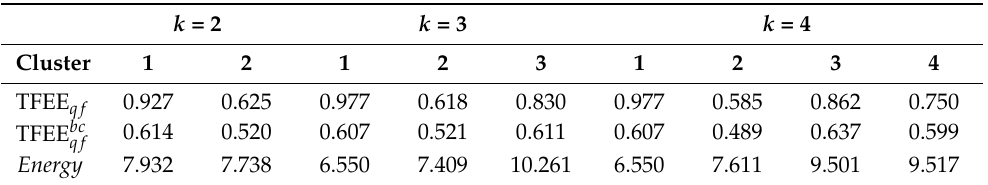
Table 5. Mean values of partitioning around medoids (PAM) for k = 2, 3, 4.